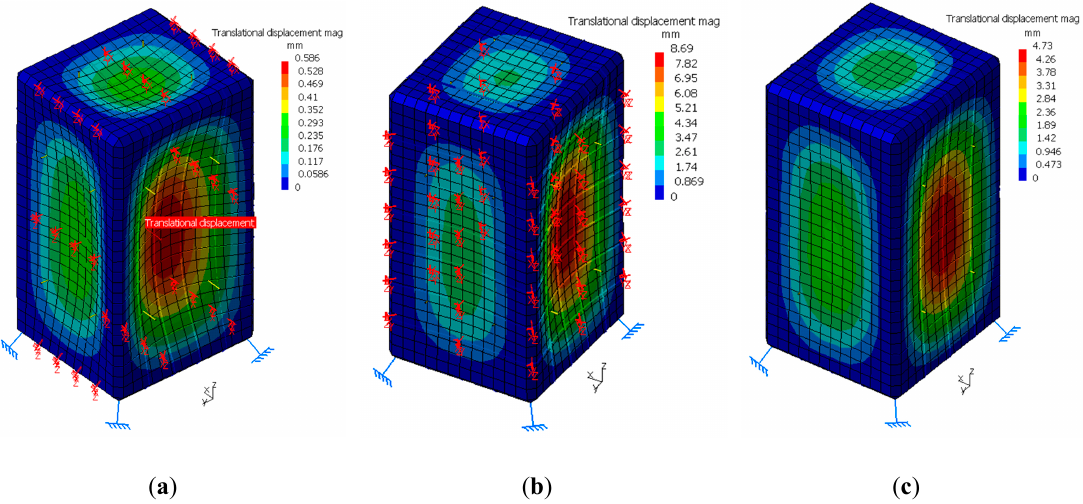
Figure 4. Deflection contours as FE results for various cases of compartments: ( a ) steel compartment, ( b ) aluminum compartment (depth of 20 m), and ( c ) aluminum compartment (depth of 60 m).